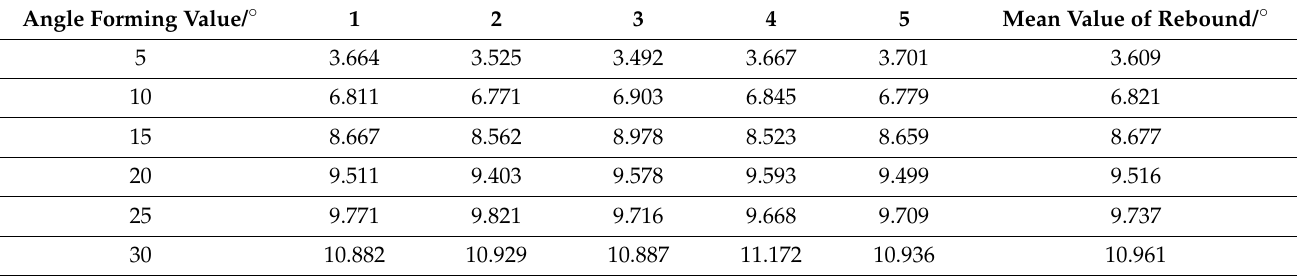
Table 3. Results of the brushing angle forming rebound